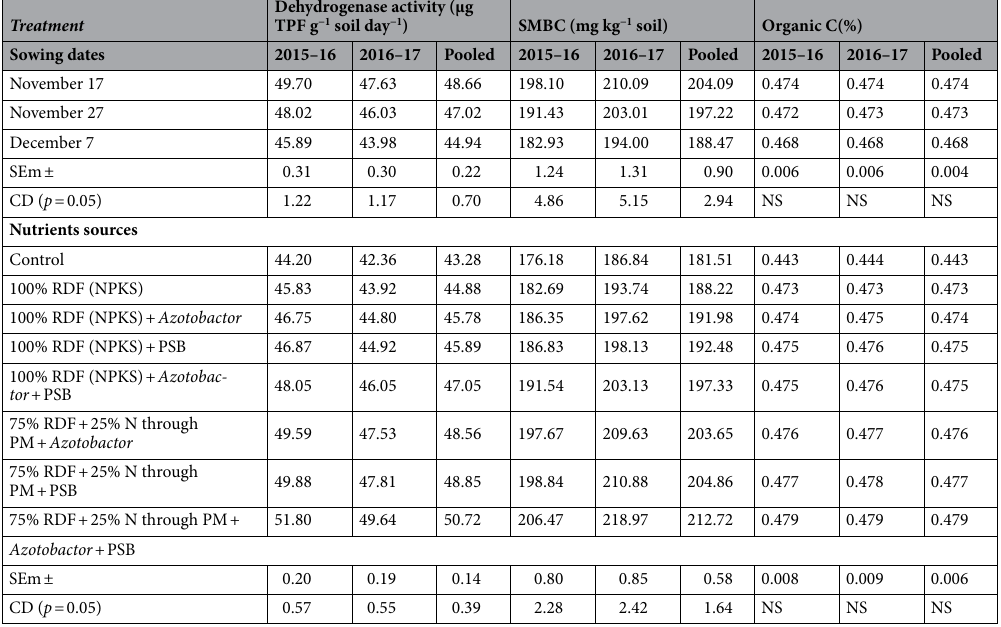
Table 4. Effect of sowing dates and nutrient sources on biological soil properties after harvest of Indian mustard. NS, Non Significant.